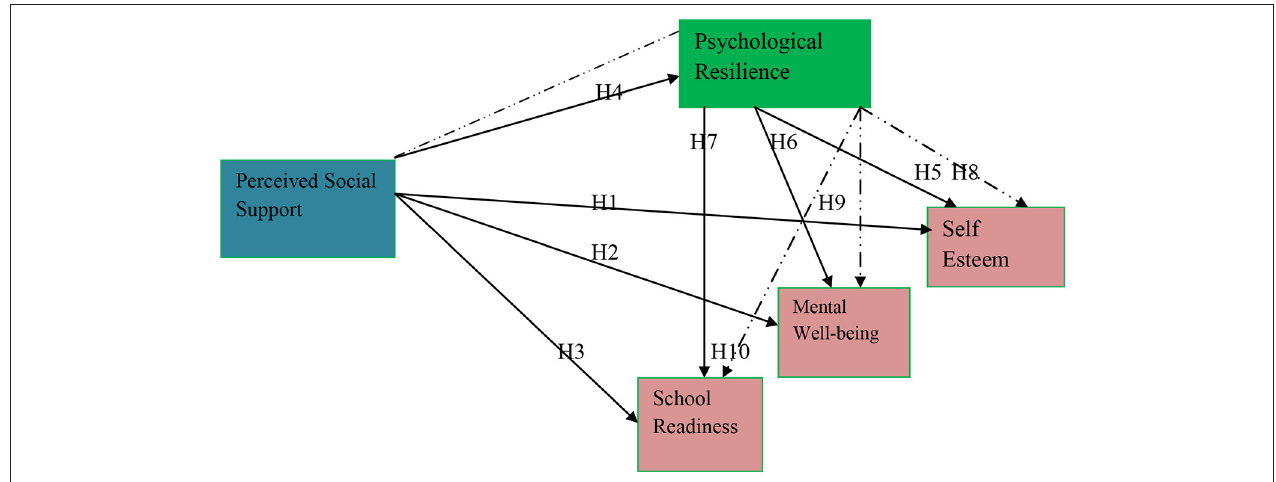
FIGURE 1 | Conceptual framework.